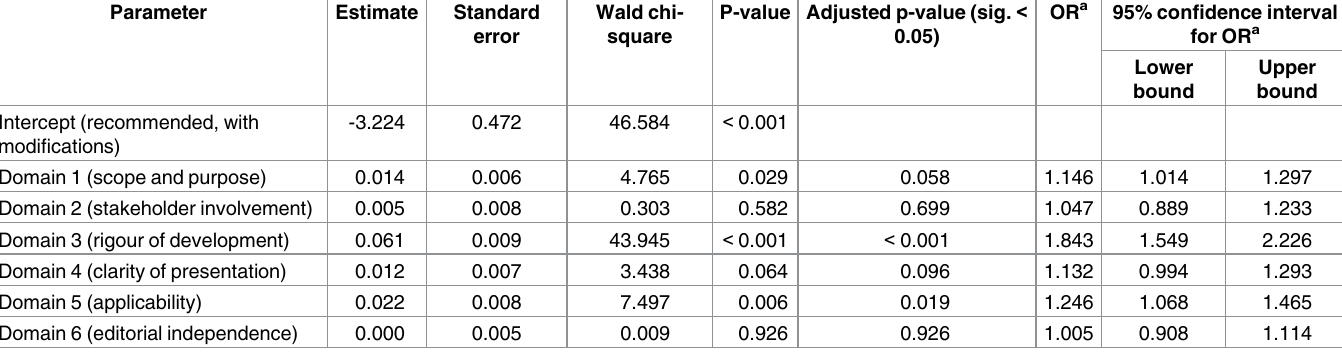
Table 4. Results of the multinomial regression analysis (independent variable: Recommendation for use for the categories; “yes, with modifica- tions” vs.